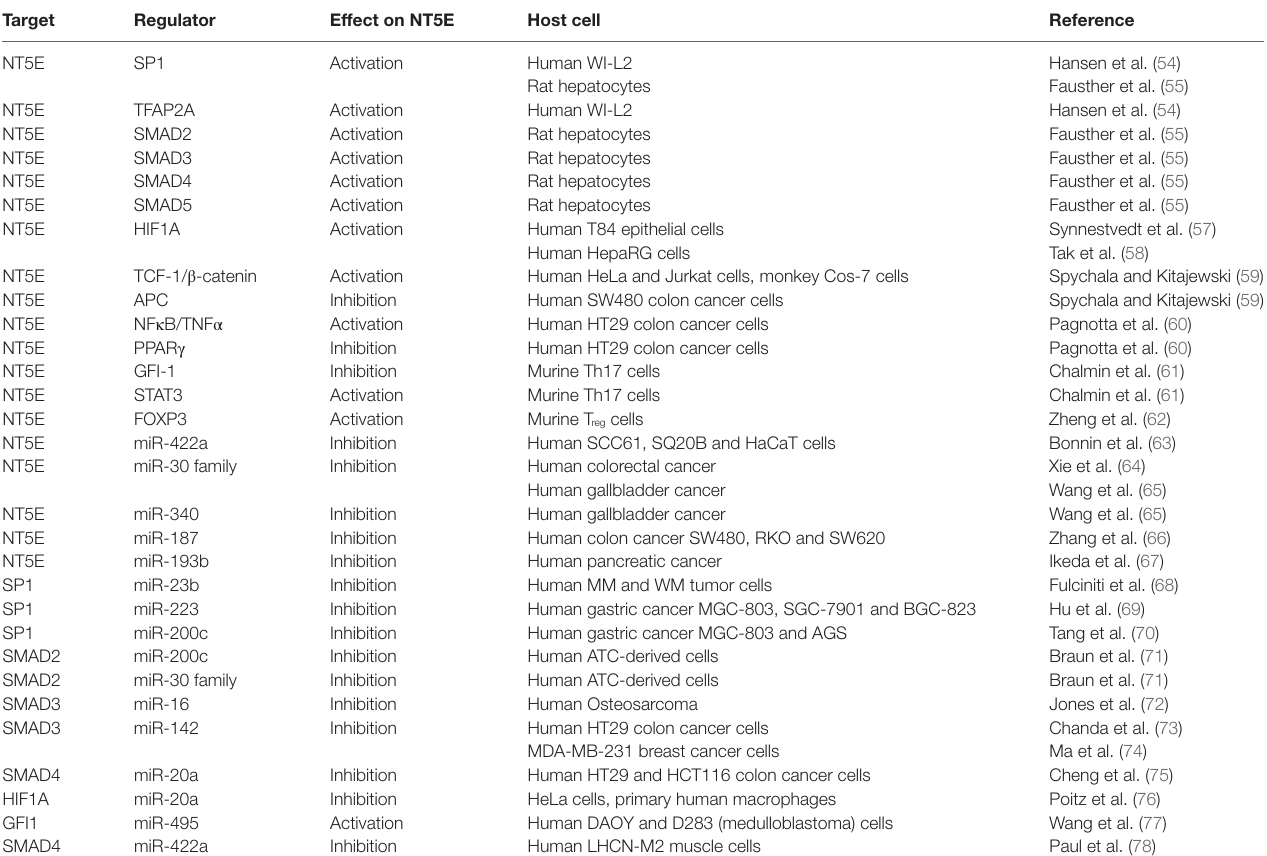
TABLe 1 | List of transcription factors and miRNAs regulating